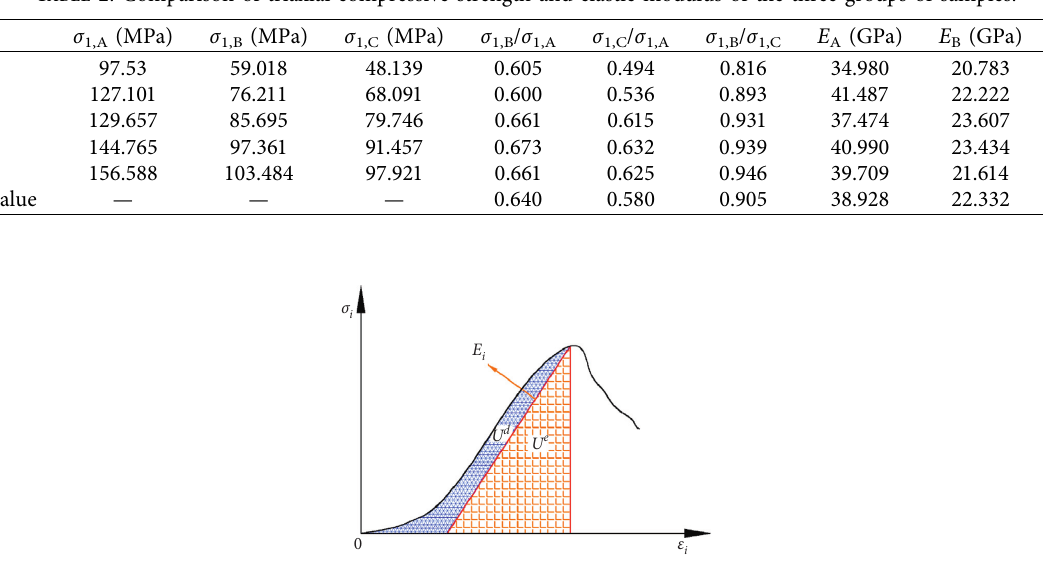
Figure 5: Relationship curve between dissipated energy and releasable strain energy of rock [16].